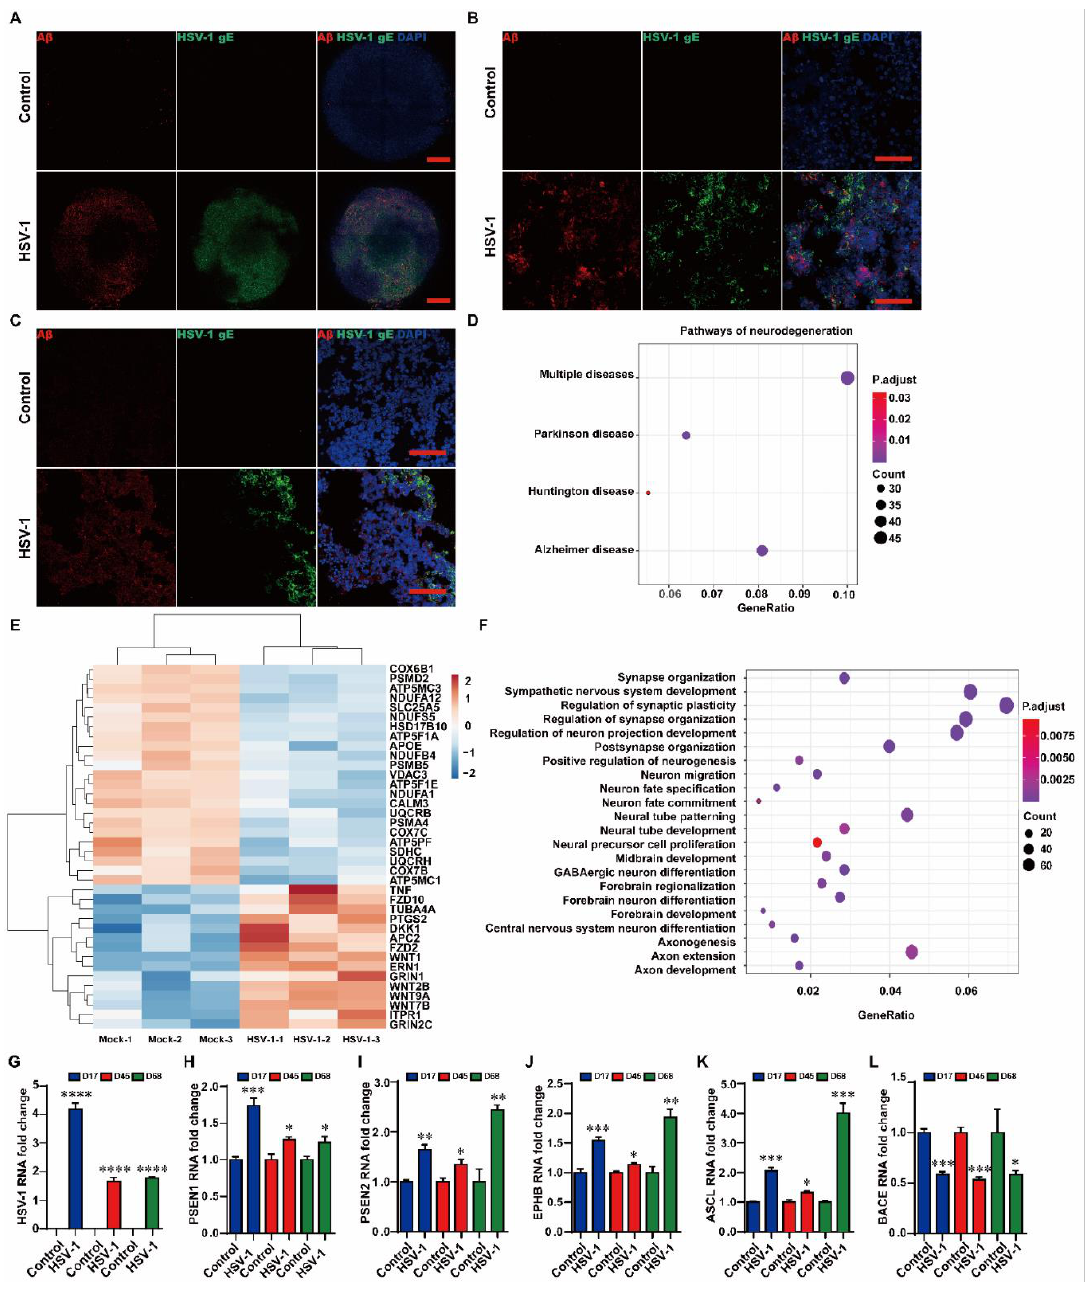
Figure 2. HSV-1 led to A β deposition in the cerebral organoids. ( A ) Whole-mount 3D immunoflu- orescence imaging of HSV-1 and A β in the cerebral organoids with or without HSV-1 infection at D14 + 3. Scale bars (red rectangle): 250 µ m. ( B , C ) The immunostaining for the HSV-1 gE-positive and A β -positive cells in the cerebral organoids with or without HSV-1 infection at D42 + 3 and D65 + 3. Scale bars (red rectangle): 100 µ m. ( D , E ) KEGG pathways enriched in the neurodegenerative diseases and the AD-related dysregulated genes in the cerebral organoids infected with the HSV-1, compared to the control. ( F ) Dot plot of selected enriched GO terms for the biological process for dysregulated genes in the cerebral organoids infected with the HSV-1, compared to the control. ( G – L ) RT-PCR analysis to monitor the mRNA expressions of HSV-1, PSEN1, PSEN2, EPHB, ASCL, and BACE in the HSV-1 infected cerebral organoids at D14 + 3, D42 + 3, and D65 + 3. The expression value was normalized to the GAPDH expression level. Data represent the mean ± SEM. * p < 0.05 vs. the control group, ** p < 0.01 vs. the control group, *** p < 0.005 vs. the control group, **** p < 0.001 vs. the control group, ( n =